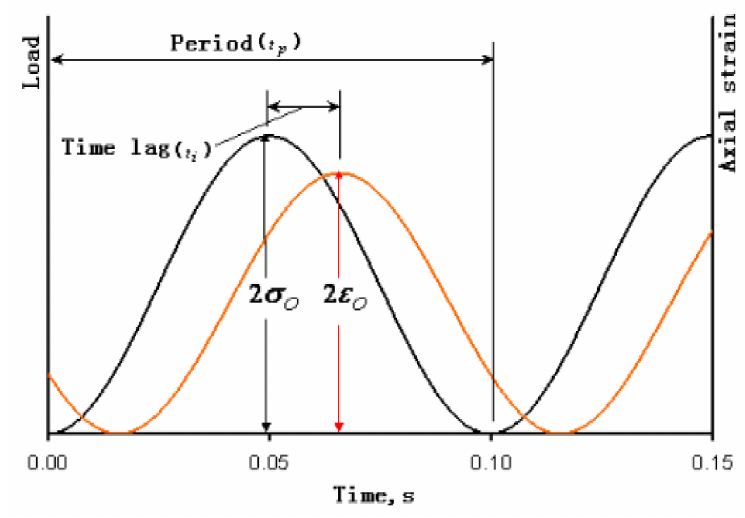
Figure 4. Loading mode of SPT uniaxial compression dynamic modulus test.